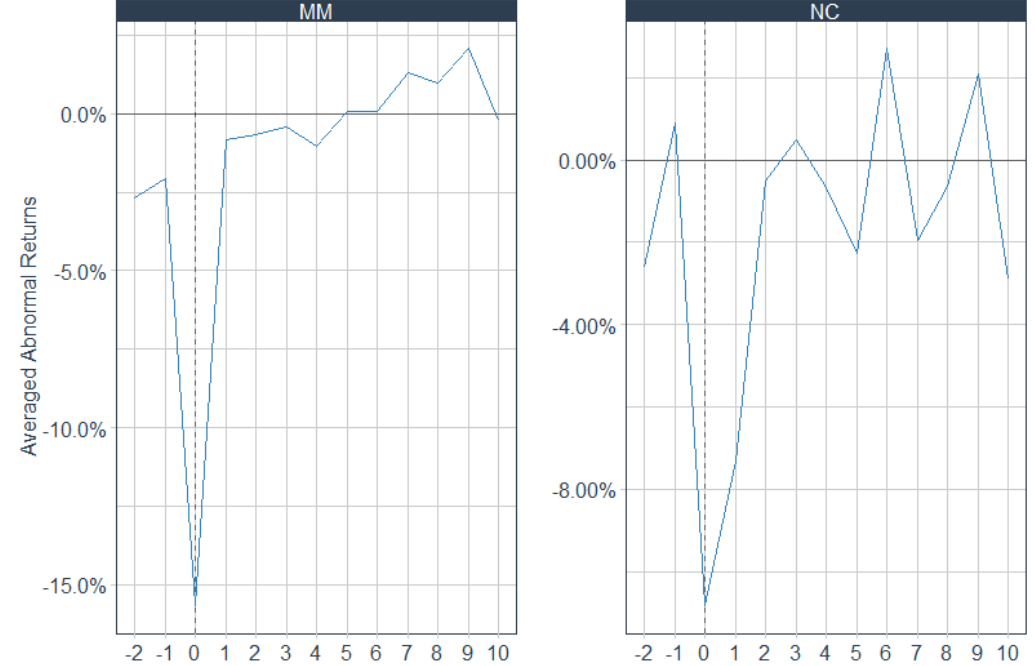
Figure 3. Average rates of return in the test window depending on the analysed market. Source: Own calculations.